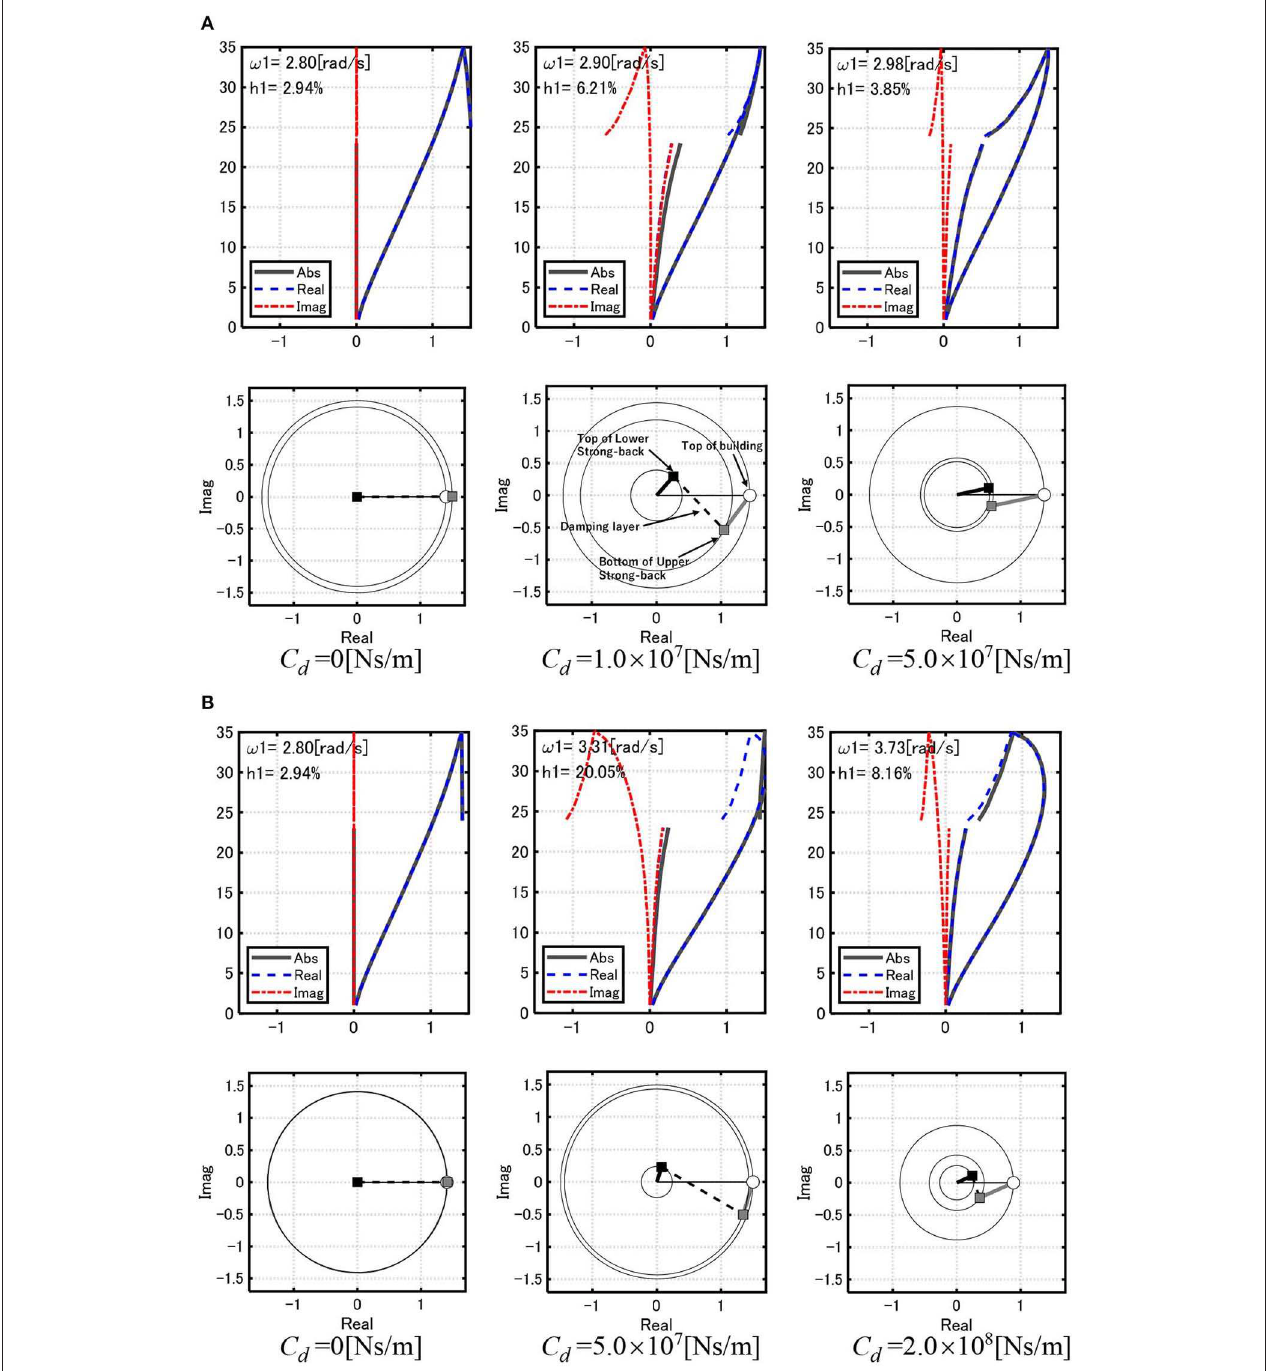
FIGURE 2 | Lowest-mode complex eigenvector multiplied by complex participation factor for three viscous damper damping coefficients. (A) Original Model and (B) Stiffer Model.